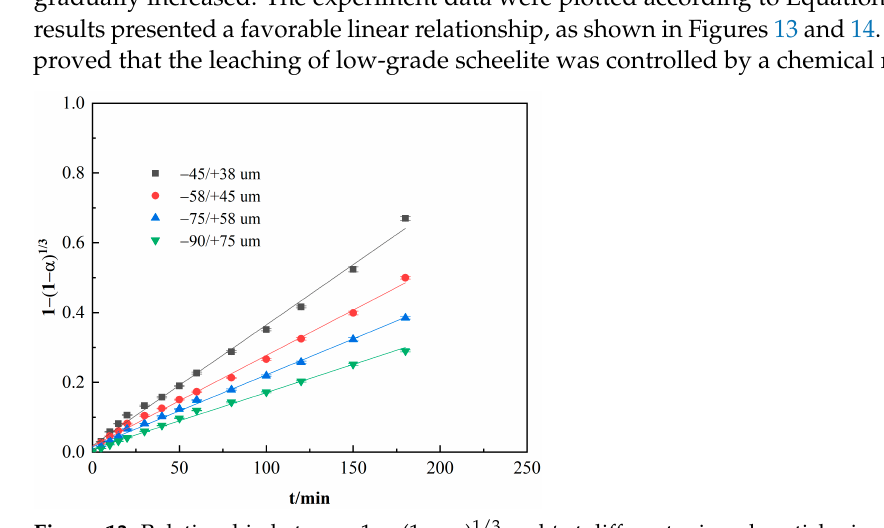
Figure 14. Plot of k and 1/ r . 3.6. Establishment of Kinetic Equation According to the above results of low-grade leaching kinetic, the kinetic equation can be expressed as: